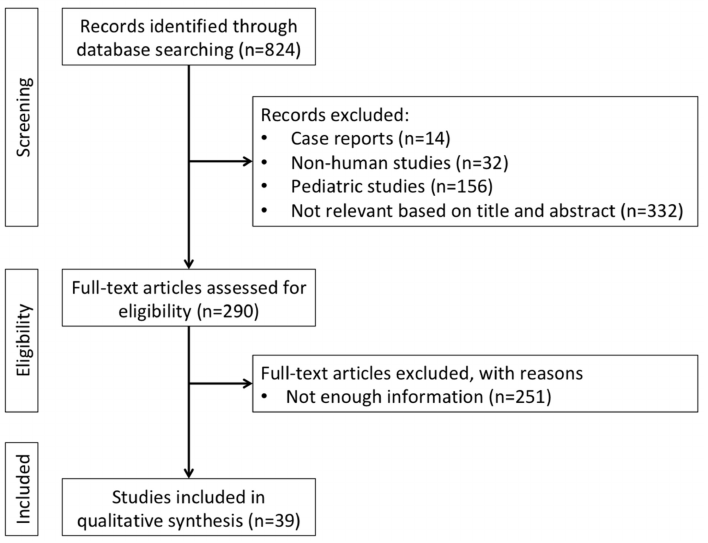
Figure 1. Flowchart of literature research and study